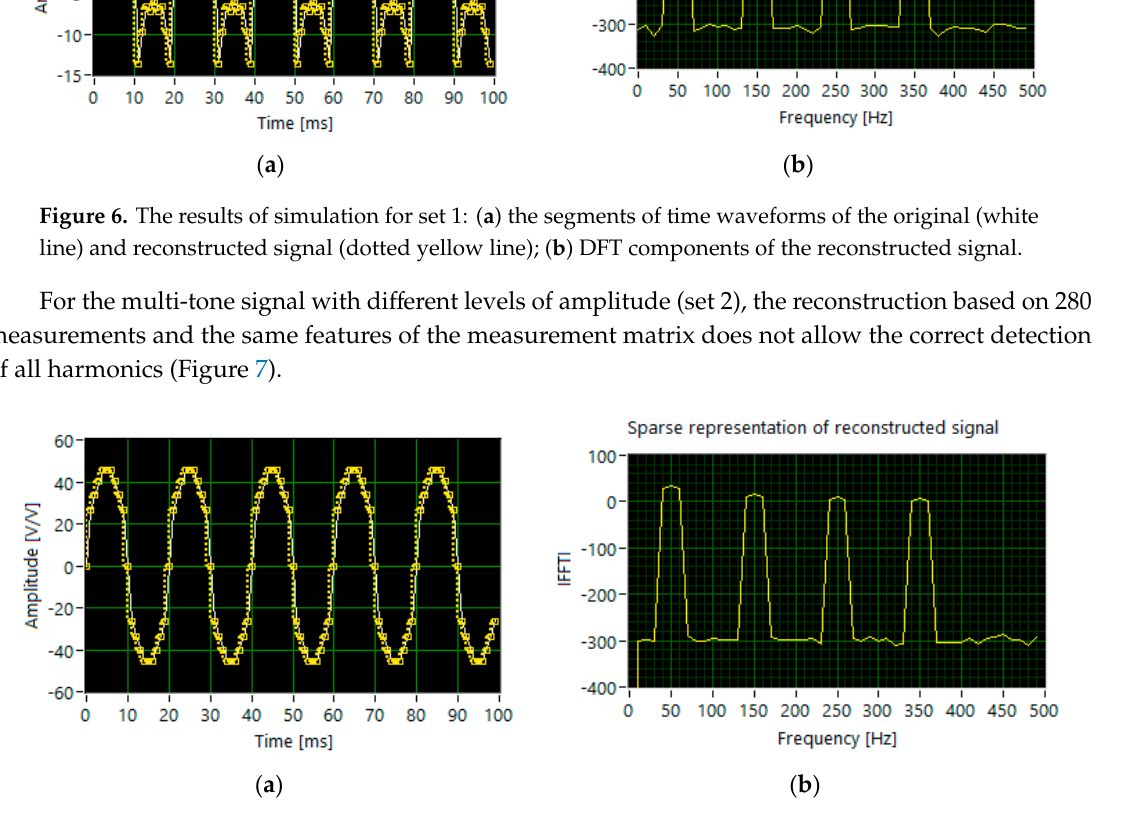
( b ) Figure 8. The results of simulation for set 3: ( a ) the segments of time waveforms of the original (white line) and reconstructed signal (dotted yellow line); ( b ) DFT components of the reconstructed signal. To study the effect of noise on the efficiency of signal reconstruction, white Gaussian noise is added to obtain a signal to noise ratio (S/N) of 20 dB. Figure 9 shows the result of a sparse reconstruction of a multi-tone waveform with insignificant differences of amplitude levels (set 1) for 210 iterations (measurements). The presence of noise adversely affects the correct identification of harmonics. In the case of set 2, in which one tone is characterized by a much higher amplitude level, adding noise does not affect the detection of harmonics (Figure 10). Noise interference distorts the precision of the spectral analysis of a multi-tone signal when there is a strong dominant component in the signal (set 3).